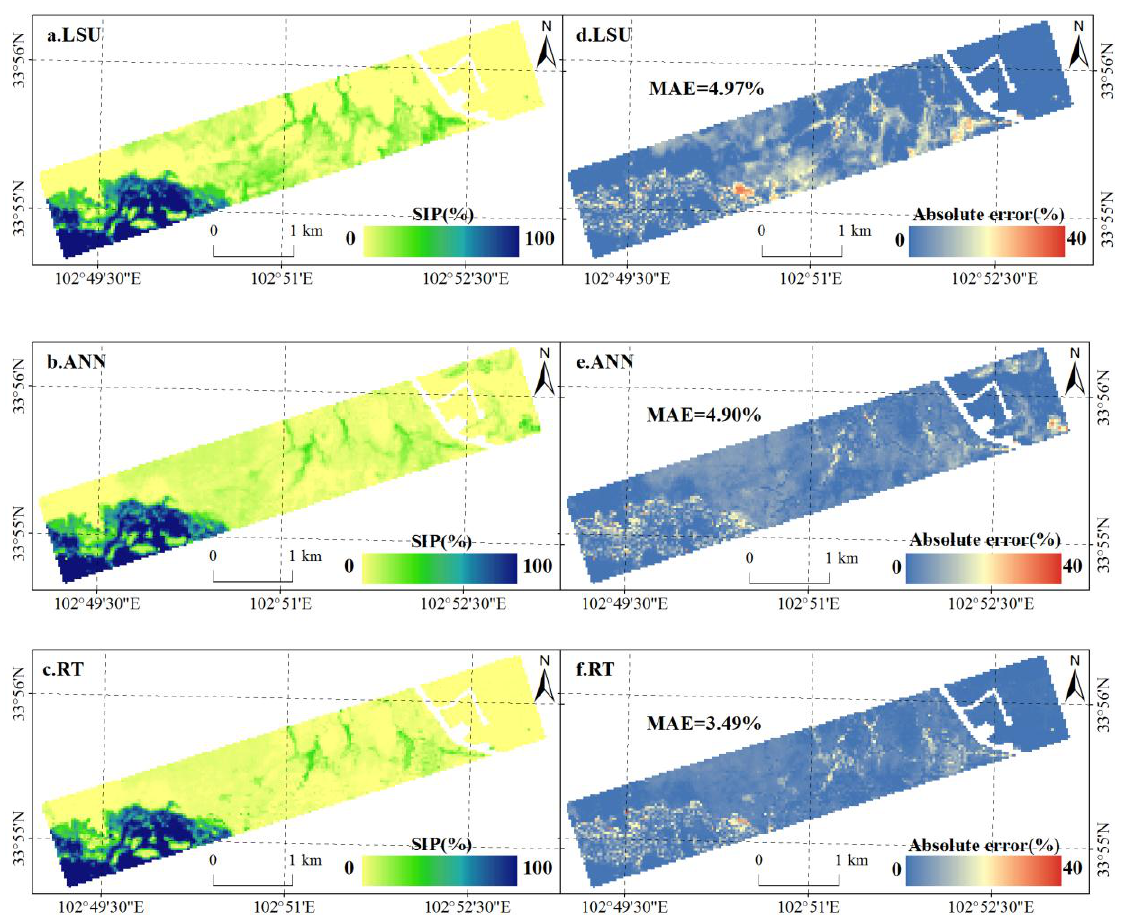
Figure 11. Spatial distribution of the estimated SIP map using LSU, ANN, and RT methods left ( a – c ); and the corresponding absolute SIP estimation error when compared to the reference SIP map in July 2014 right ( d – f ).